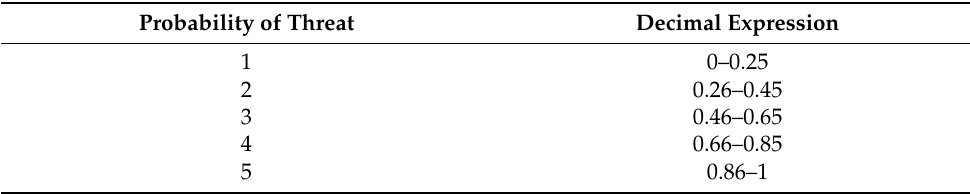
Table 1. Decimal scale of probability of threat (own resource).